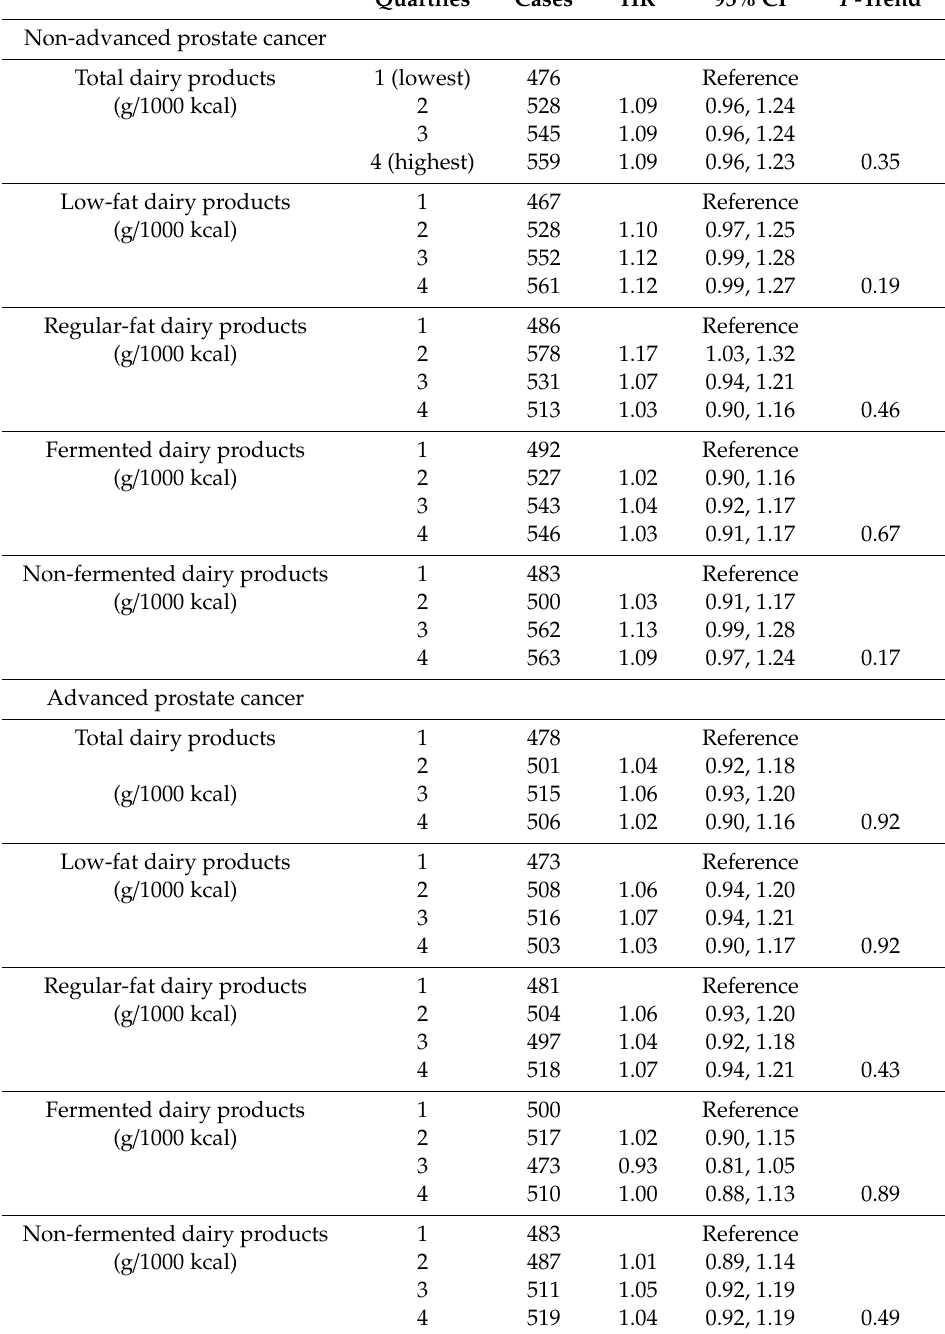
Table 4. Risk of prostate cancer by quartiles of dairy product intake stratified by advanced or non-advanced prostate cancer